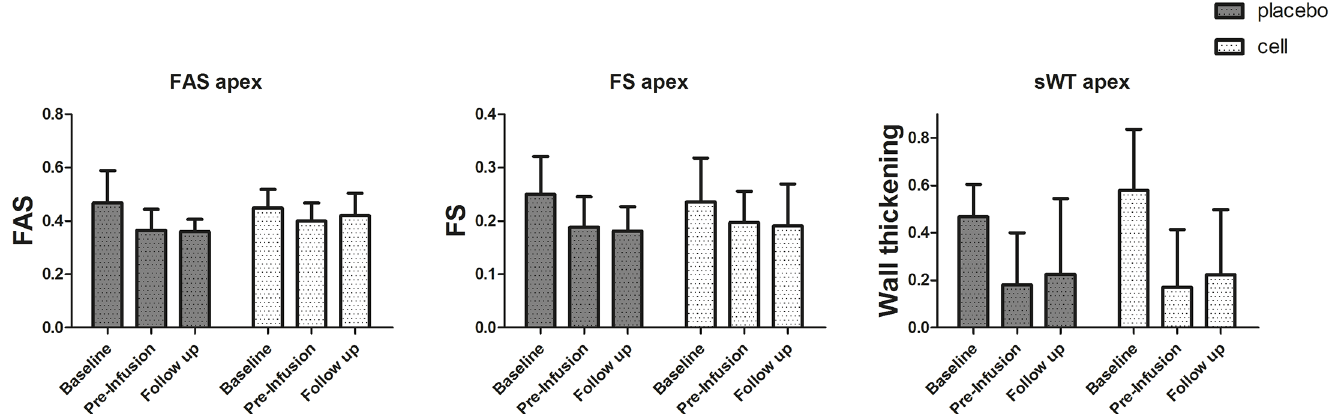
Fig 4. Functional measurements by echocardiography. Mean and SD, n = 8 per group. FAS Fractional area shortening, FS Fractional shortening, sWT Septal wall thickening at the level of the apex.